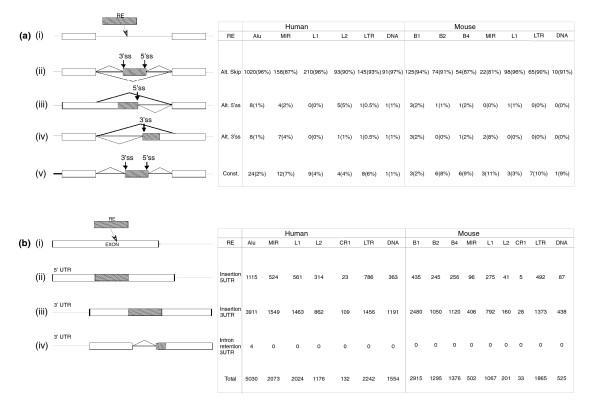
How TEs affect the human and mouse transcriptome. (a) Summary of the effect of (i) exonization of TEs on the transcriptome; of the effect of exonization that (ii) creates an alternatively skipped exon, (iii) transforms an existing exon to an alternative 5'ss exon, or (vi) transforms an existing exon to an alternative 3'ss exon; or of the effect of exonization that (v) creates a constitutively spliced exon. The table on the right shows the corresponding numbers of transposed elements (TEs). (b) Summary of the effect of TE insertions in the first or last exon. Panel i shows the insertion of TEs (gray box) into an exon (white box). The insertion of the TEs can cause an enlargement of the first or last exon (panels ii and iii), or, in some cases, activates intronization (generating an alternatively spliced intron that splits the last exon into two smaller exons; panel iv). The numbers of those events according to TE family are shown on the right-hand side.